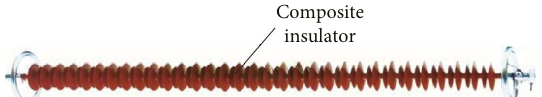
Figure 5: Te FXPW-1000/300 composite